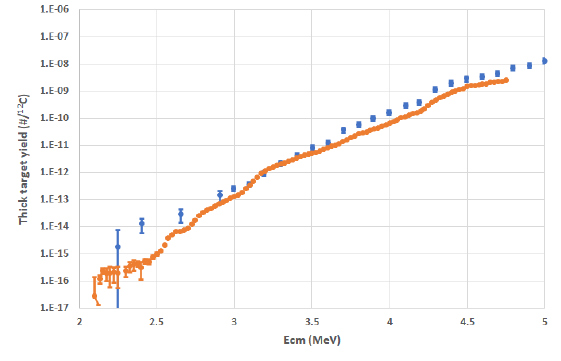
Figure 2. (Color online) Comparison of the thick target yields of the 1634-keV transition measured by Barrón-Palos et al . (blue points) and Spillane et al . (orange